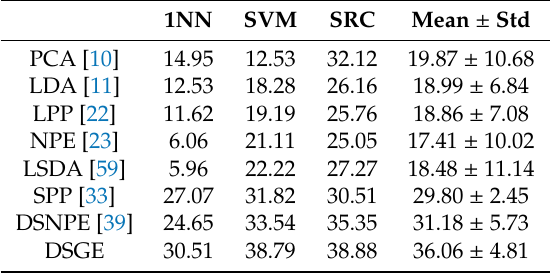
Table 7. The recognition results of di ff erent algorithms by di ff erent classifiers on the LFW database.